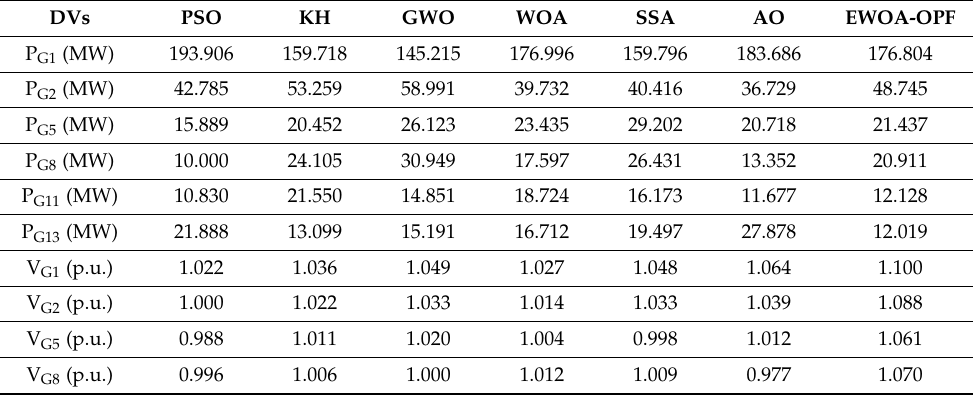
Table 7. Results of OPF for IEEE 30-bus test system on Case